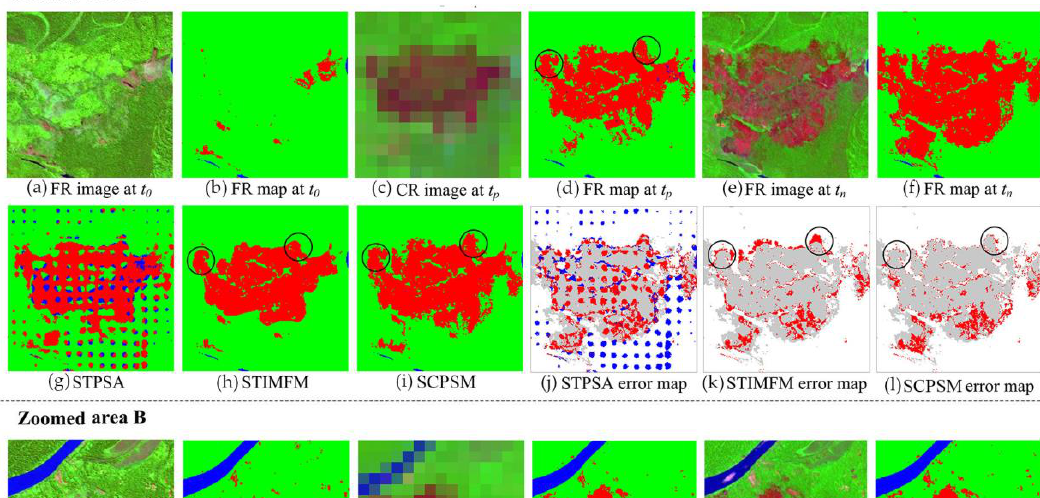
Figure 8. The result of land cover maps predicted from different methods and the corresponding error maps in the experiment for the forest fire experiment. ( a ) STPSA; ( b ) STIMFM; ( c ) SCPSM; ( d ) STPSA error map; ( e ) STIMFM error map; ( f ) SCPSM error map.